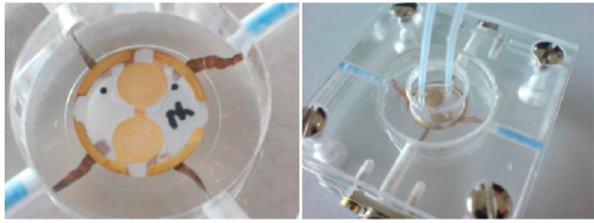
Figure 1. Left : Quartz crystal microbalances (QCM) positioned on the copper electrode wires. Right : Placement of the lid with inlet and outlet on top of the sensor.